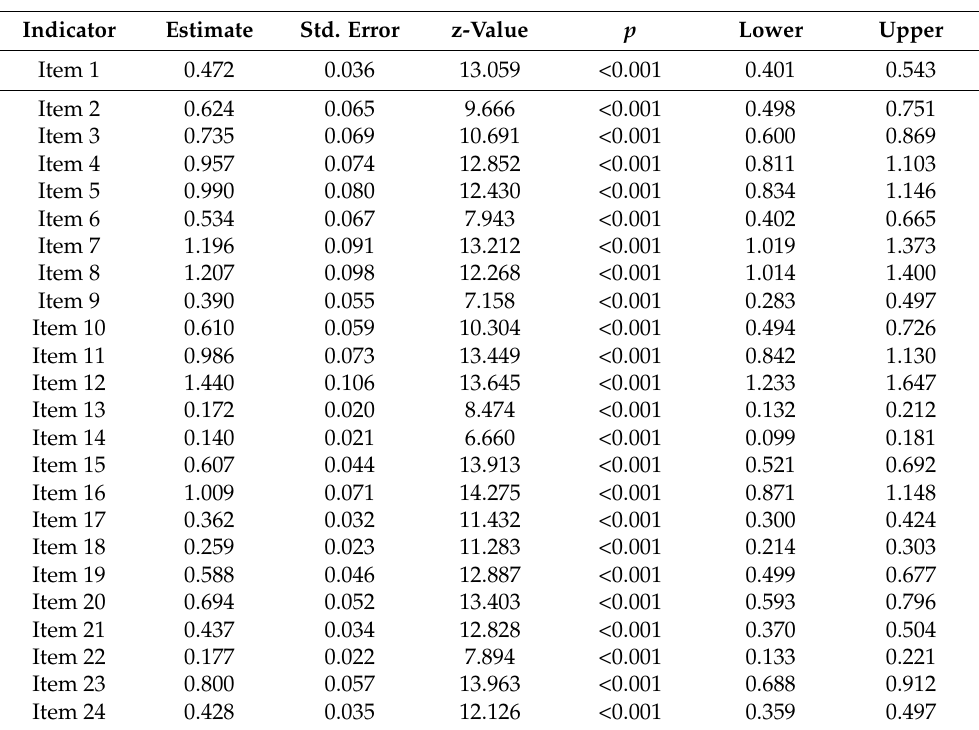
Table 6. Residual variances.